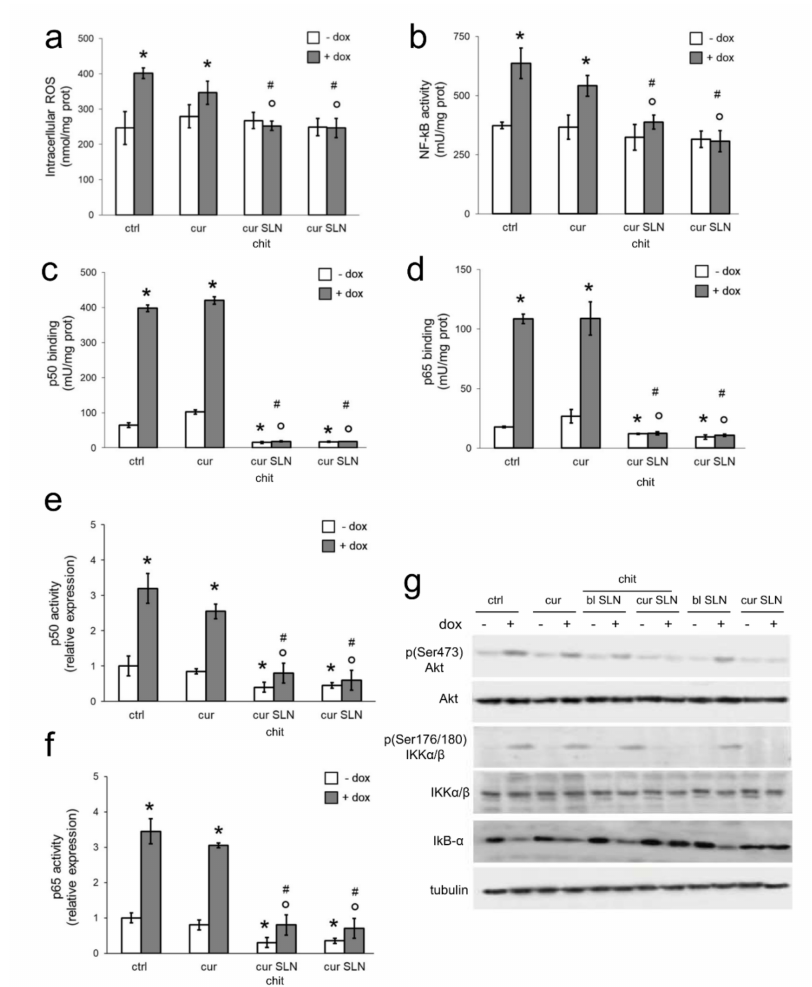
Figure 3. E ff ects of CURC-loaded SLNs on intracellular ROS, NF-kB activation, and